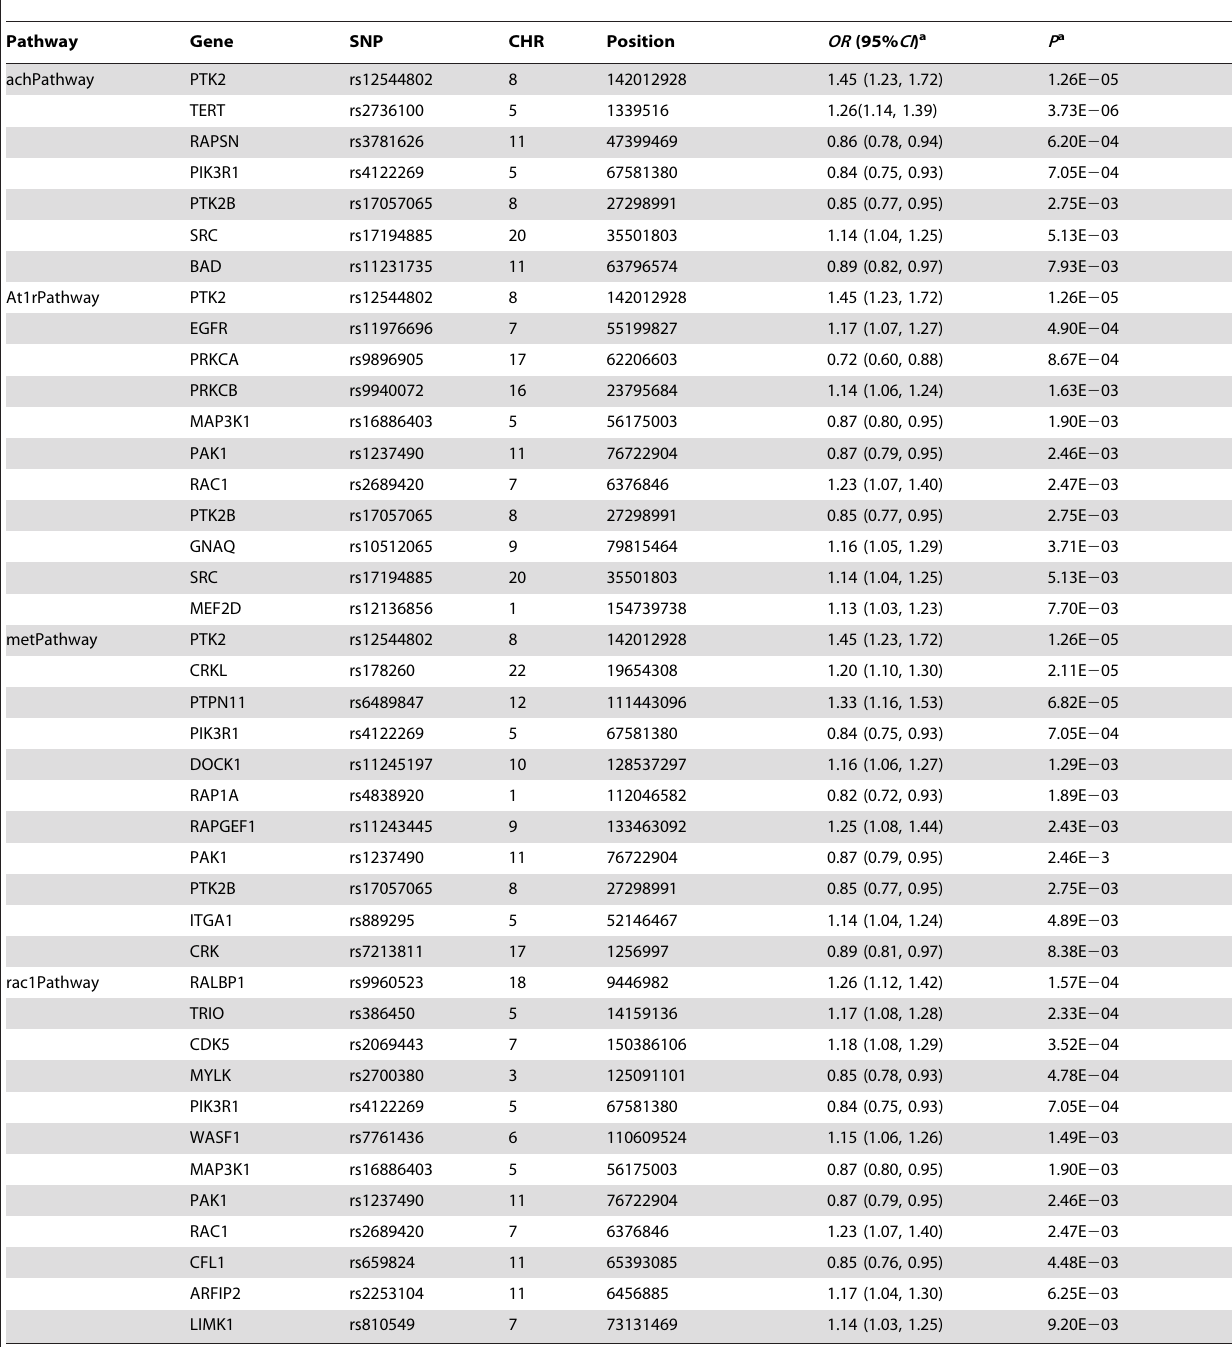
Table 2. Association results of representative SNPs at P , 0.01 for genes in four identified pathways.